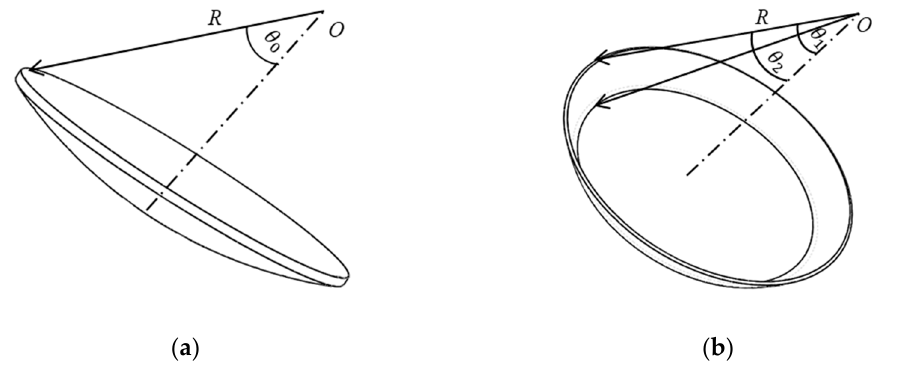
Figure 2. Sketch of the sensing plates ( a ) CP s 1 ~ CP s 4 ( b ) CP s 5 and CP s 6 .